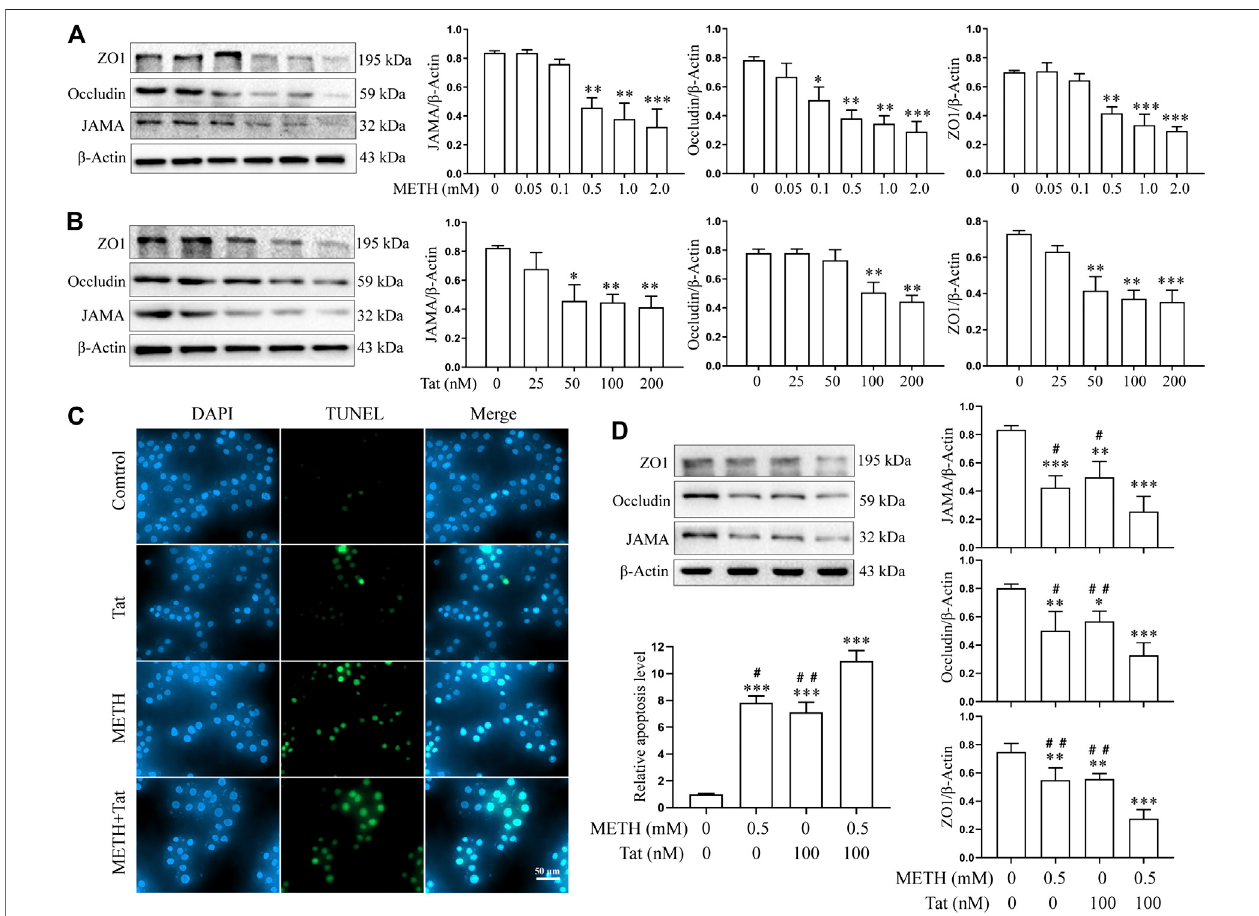
FIGURE 1 | METH and HIV-Tat synergistically damage the BBB model in vitro . (A, B) Western blot was performed to determine JAMA, Occludin, and ZO1 expression levels in the hCMEC/D3 cells treated with a gradient concentration of METH or HIV-Tat for 24 h. After the cells were treated with 0.5 mM of METH and/or 100 nM of HIV-Tat for 24 h, (C) apoptosis was assessed by TUNEL assay (Scale bar: 50 µm), apoptosis level was determined by the number of TUNEL-positive cells expressed as a percentage of the total cell number (analyzed by Image J software); (D) western blot was performed to determine JAMA, Occludin, and ZO1 expression levels. Compared with the control, * p < 0.05, ** p < 0.01, *** p < 0.001; compared with the METH + HIV-Tat, # p < 0.05, ## p < 0.01, n (cid:1)